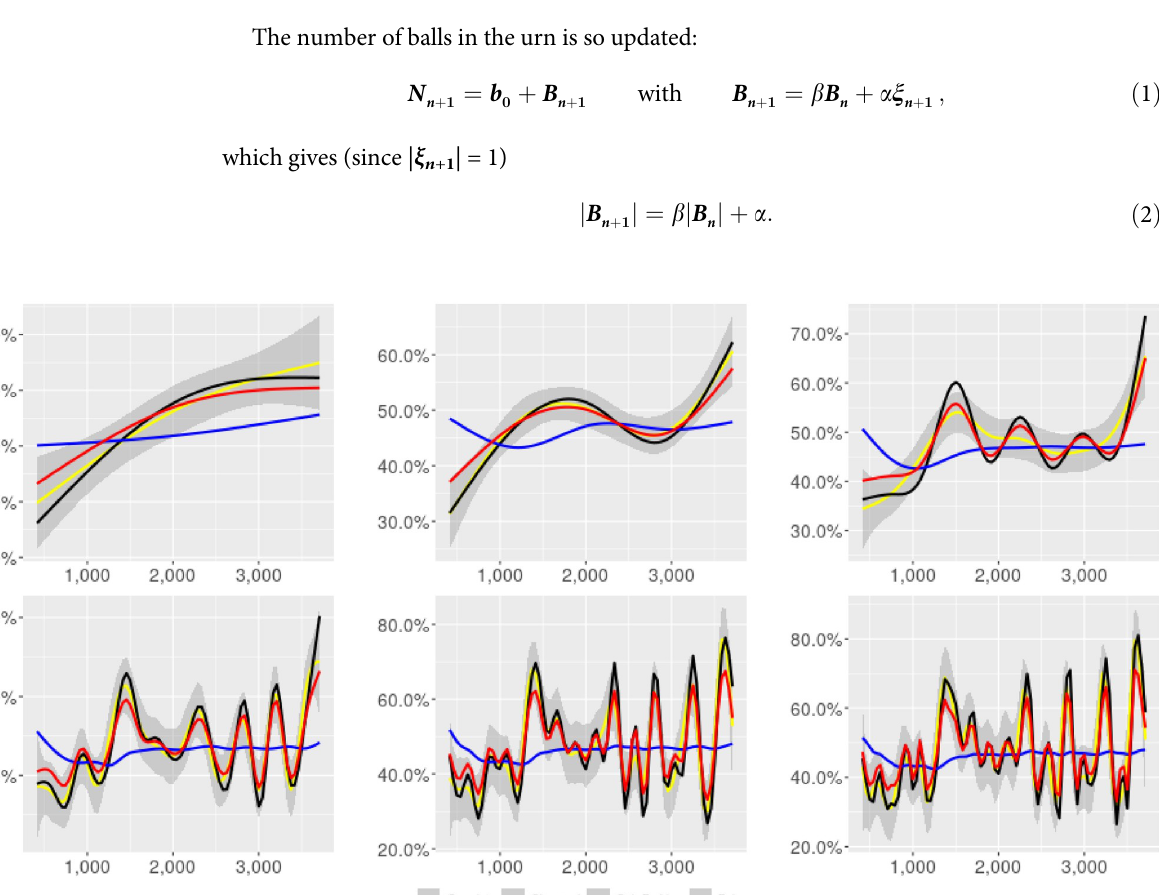
PLOS ONE | https://doi.org/10.1371/journal.pone.0249634 April 15,